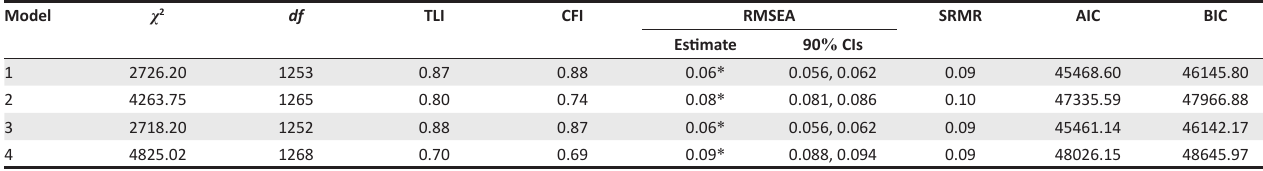
TABLE 3: Fit statistics of competing measurement models.